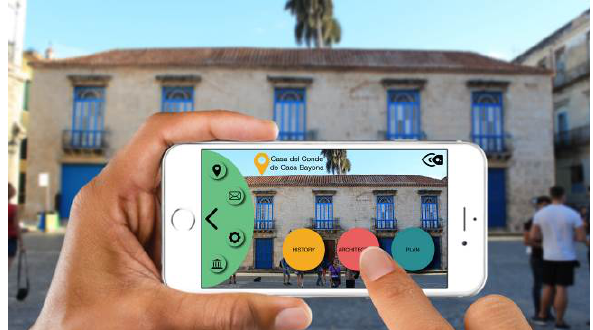
Figure 13. Example of an application of immersive virtual reality (Plaza de la Catedral)